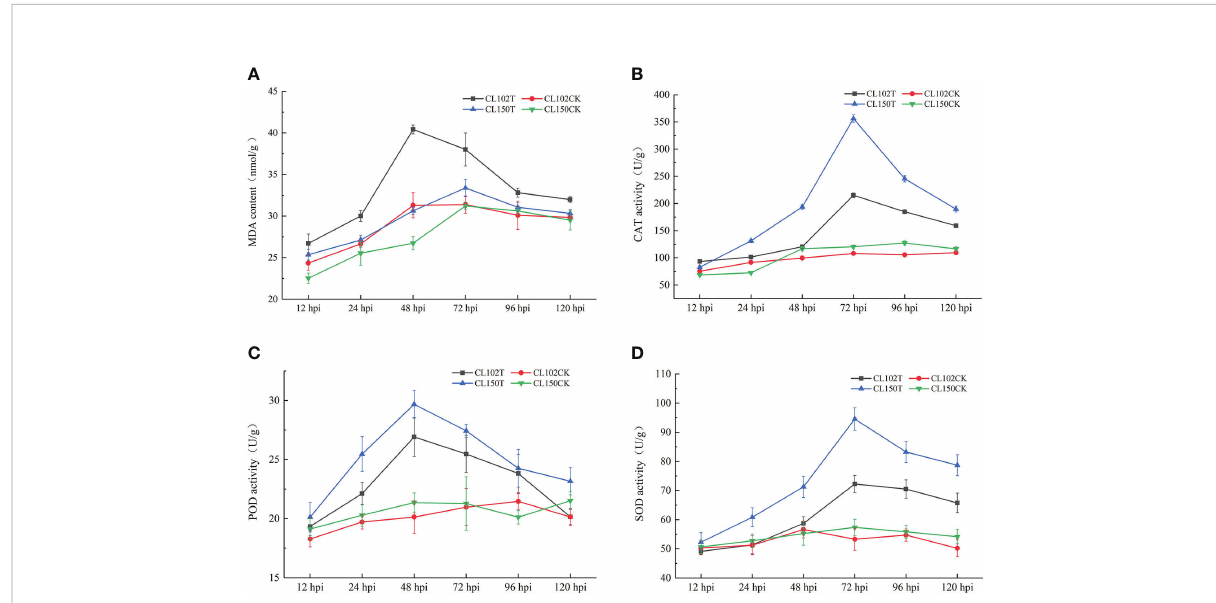
FIGURE 1 Measurement of the physiological indicators of different timepoints. (A) The content of MDA. (B) The activities of CAT. (C) The activities of POD. (D) The activities of SOD. Each value represents mean ± standard error (n =